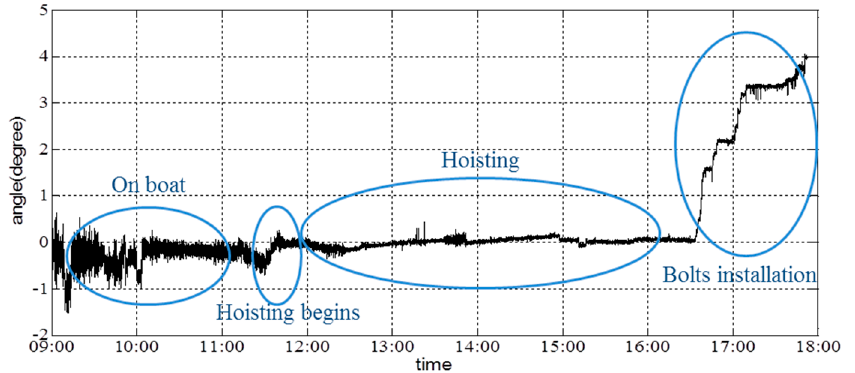
Figure 27. Angle about the y -axis of the girder.